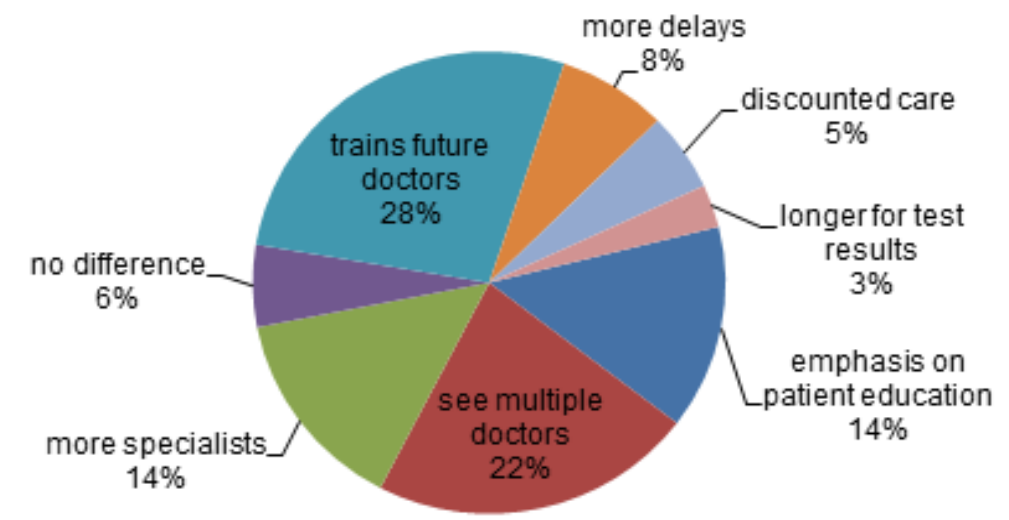
Figure 2. Aspects of teaching hospitals compared to other hospitals by waiting room